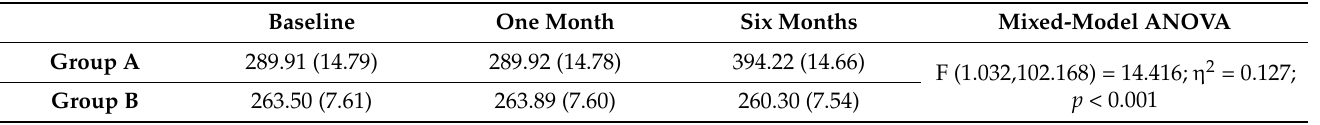
Table 2. Central macular thickness changes over time.